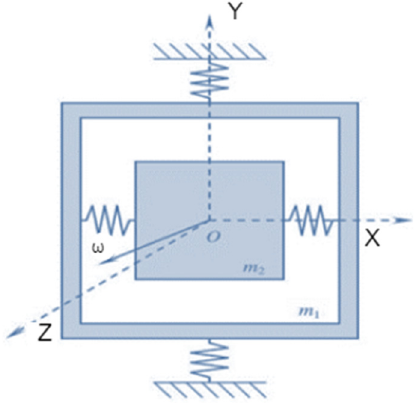
Figure 2. Perception of the Coriolis force.